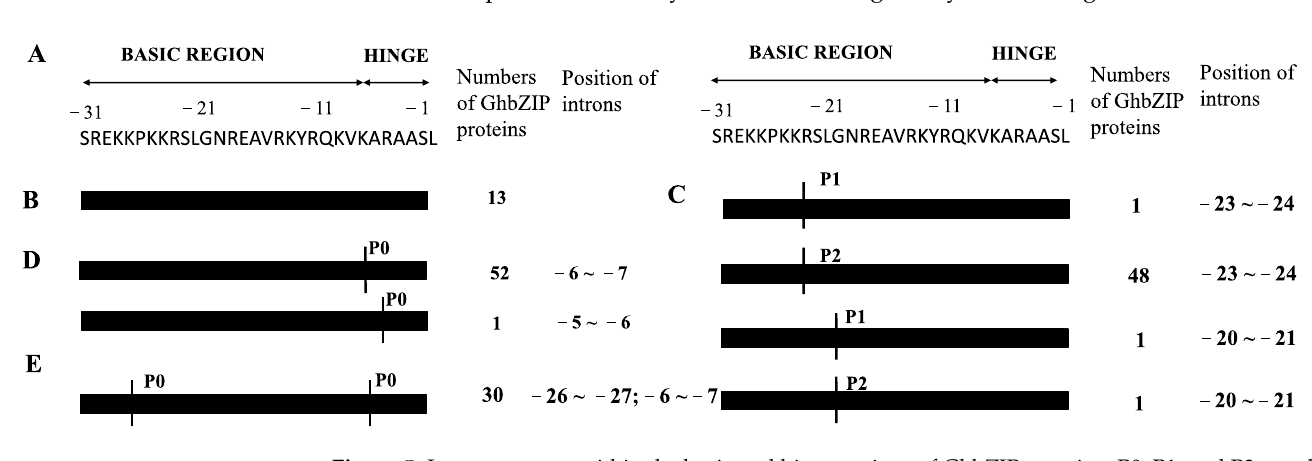
Figure 5. Intron patterns within the basic and hinge regions of GhbZIP proteins. P0, P1, and P2 stand for the intron splicing phases. P0, P1, and P2 represent the splicing occurring after the third, second, and first nucleotides of the codon, respectively. The black bars represent the sequence of basic and hinge regions. The vertical lines denote the positions of intron splicing phases. ( A ) The representative amino acid of the conserved bZIP domain. ( B ) Thirteen GhbZIP proteins had no intron in the bZIP domain. ( C ) GhbZIP proteins had one intron present in the hinge region. ( D ) GhbZIP proteins had one intron present in the basic region. ( E ) GhbZIP proteins had two introns each in the hinge region and basic region.